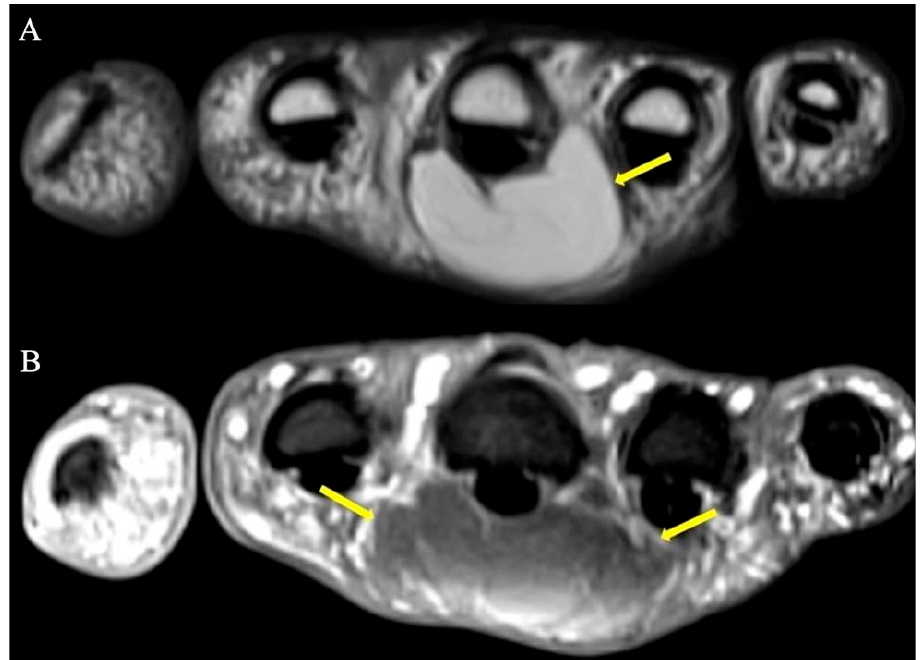
Figure 5. Palmar lipoma hand ‐ simulating retinacular cyst. ( A ) T1 and ( B ) fat ‐ suppressed T2 ‐ weighted axial images demonstrating a lipoma (arrows) situated just volar to the 3rd metacarpal and associated flexor tendon. Note the homogenous appearance and similar signal characteristics to subcutaneous fat on both pulse sequences.